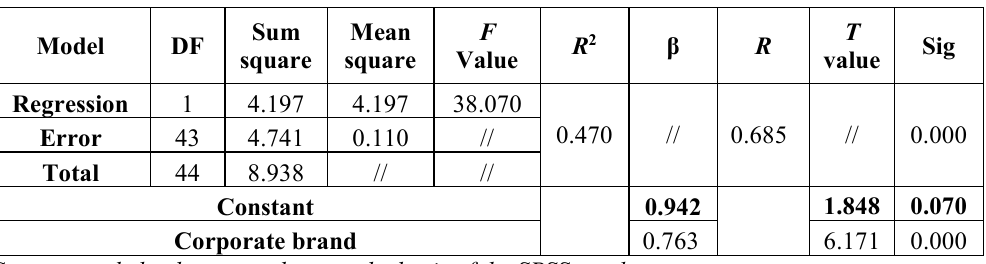
Table 6 . The Results of the Impact Hypothesis